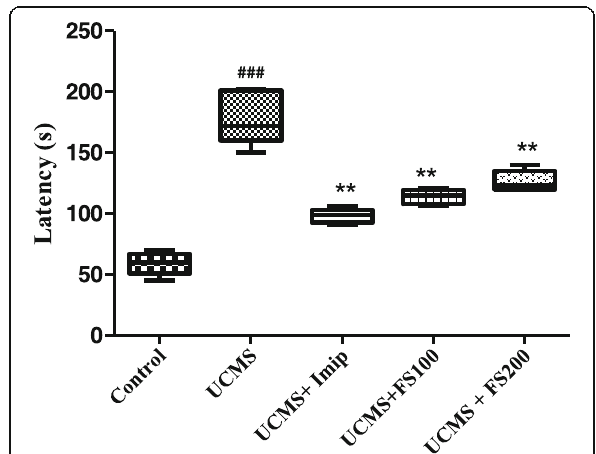
Fig. 8 Effect of hydromethanolic extract of F. sycomorus on the latency in the novelty-suppressed feeding test in control and CUMS rats. Values are mean±SEM ( n =6). ### P <0.001 compared to control. ** P <0.01 compared to CUMS group